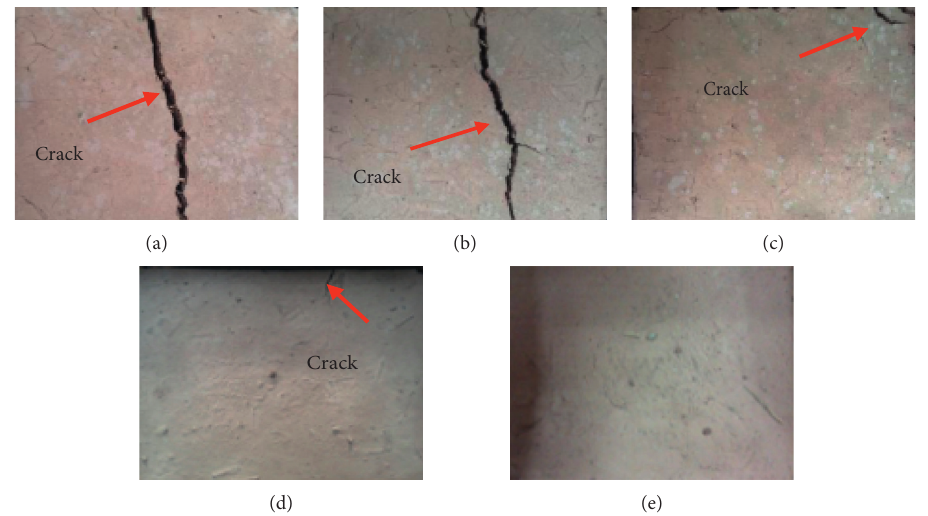
Figure 10: Dry shrinkage cracks on the surface of composite root-soil of vetiver roots with different root contents: (a) pure soil; (b) root content is 0.78g/1000 cm 3 ; (c) root content is 1.56g/1000cm 3 ; (d) root content is 2.34g/1000 cm 3 ; (e) root content is 3.12g/1000 cm 3 . netCrossbar interpenetration